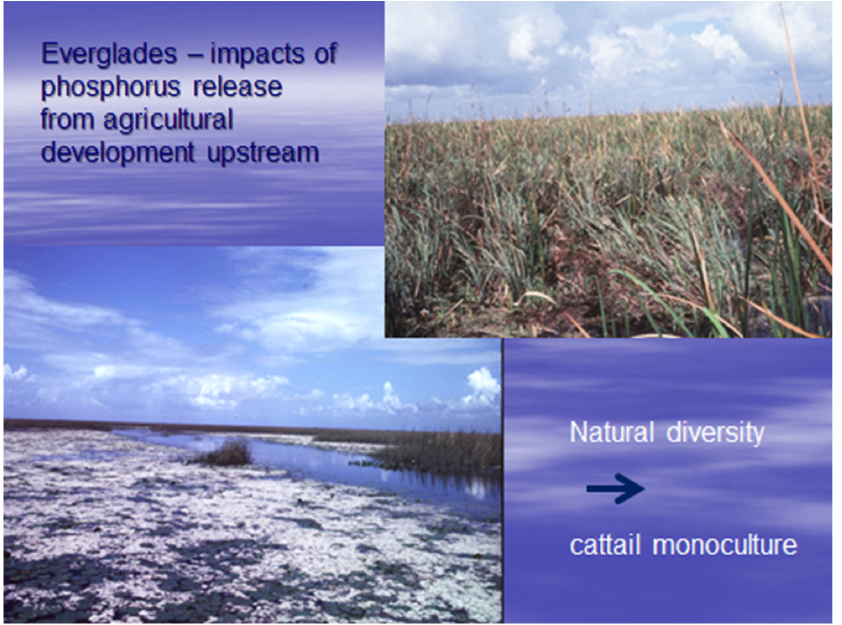
Figure 29. Wetland stresses and impacts on ecosystem structure and functioning in Everglades. Source: Edward Maltby.